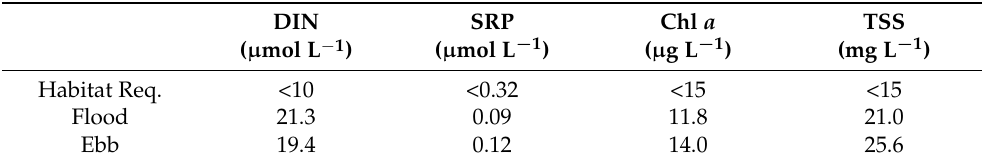
Table 8. SAV habitat requirements for the mesohaline portion of Chesapeake Bay, and flood and ebb concentrations (mean of May and July